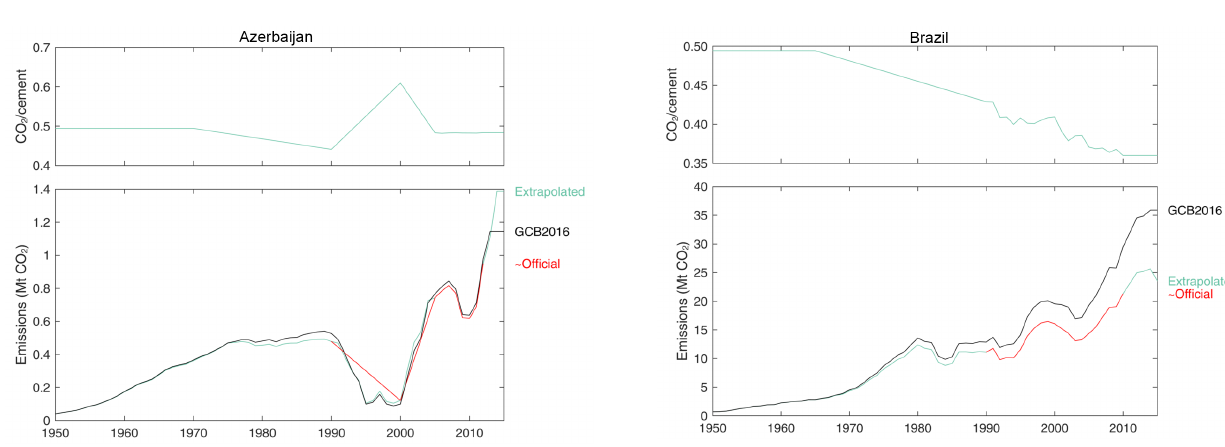
Figure C11. Revised cement emissions for Azerbaijan.